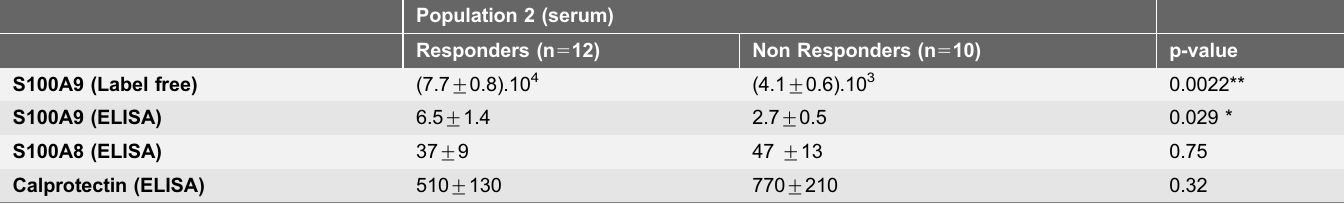
Table 2. Absolute and relative abundance of S100 proteins in serum